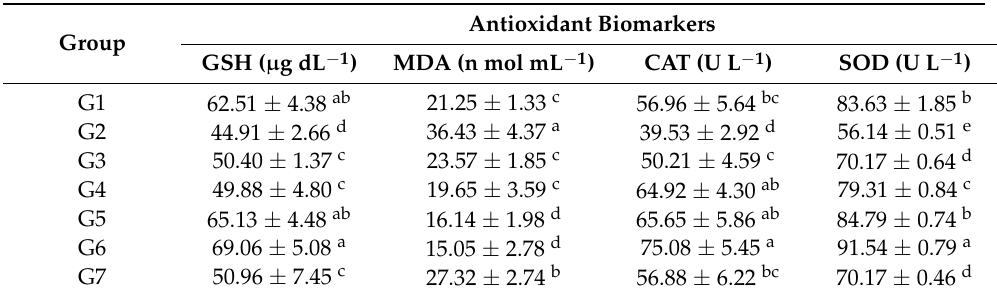
Table 7. Effects of oral administration of probiotic-enriched FCM combined with S. officinalis on antioxidant biomarkers in Streptozotocin-induced diabetes in rats (mean ± SE), n = 6.